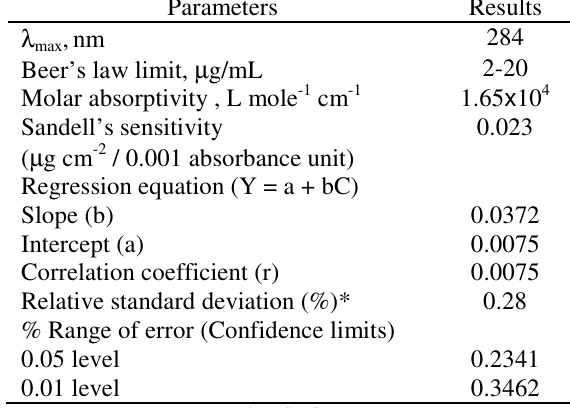
Table 1. Optical characteristics and precision of the proposed